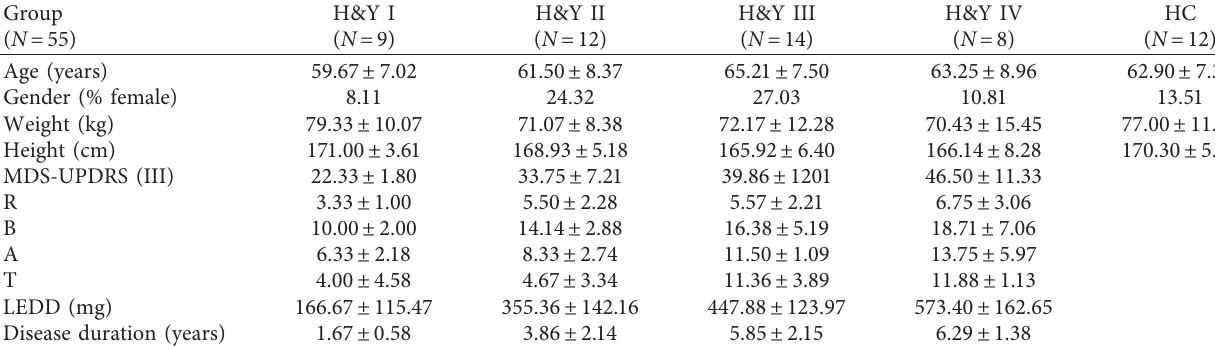
Table 1: Participant demographics.